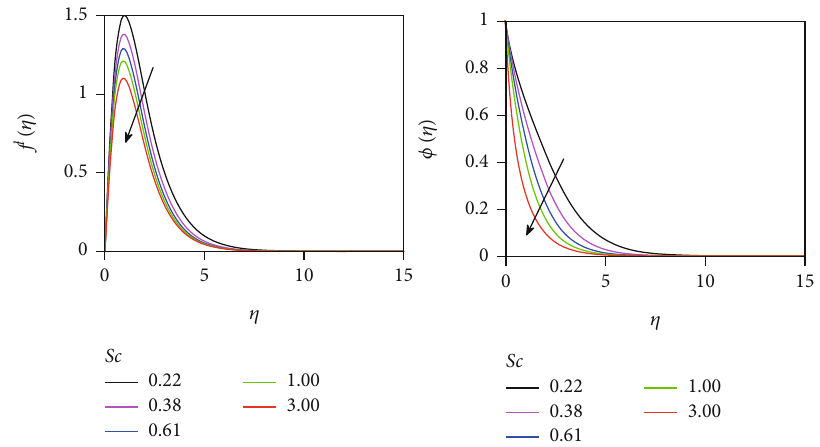
Figure 5: Signi fi cance of the Schmidt number on velocity and concentration